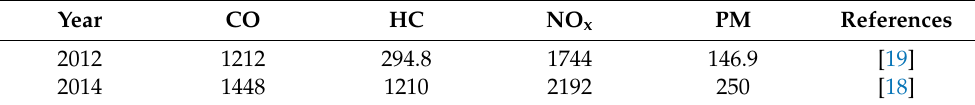
Table 7. Pollutant emissions from AM in China